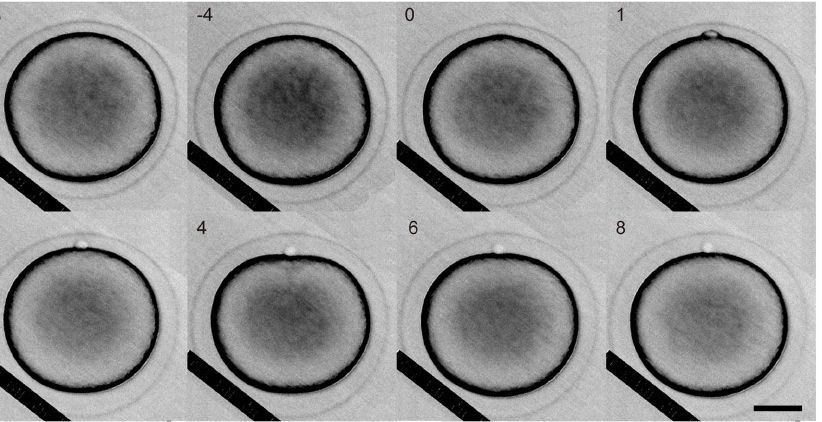
Figure 3. Shape change of a starfish oocyte during meiotic cell division. The top side is the animal pole. Numbers shown are the time after the onset of the bulge formation. Scale bar, 50 m m.